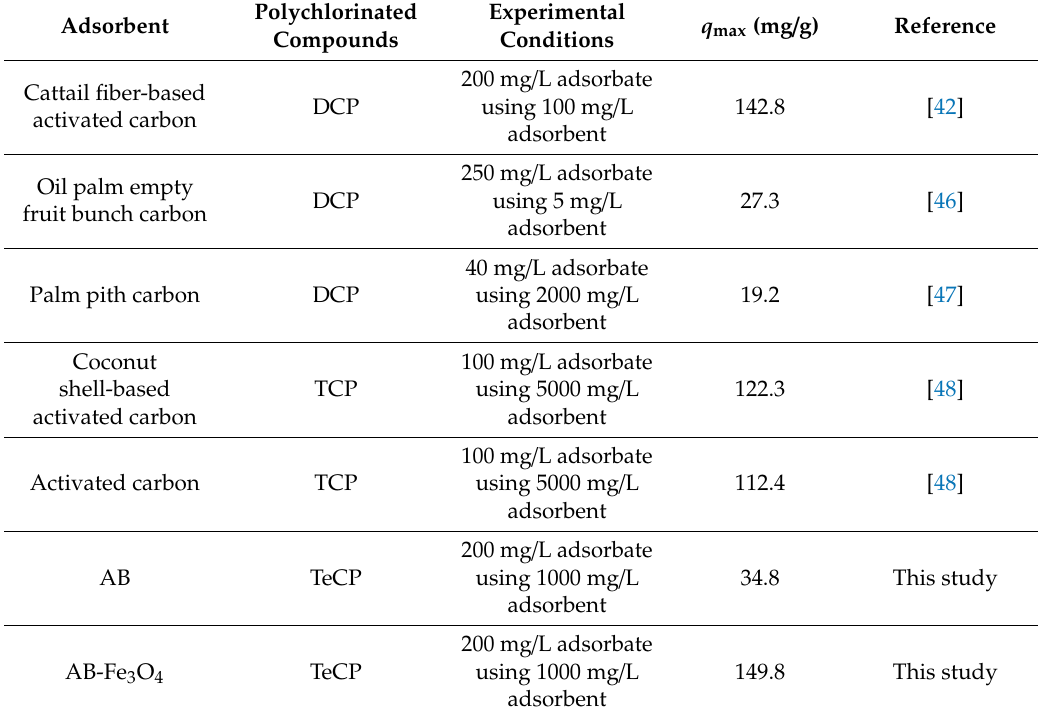
Table 4. Comparison of polychlorinated compounds removal by reported adsorbents in the literature and this